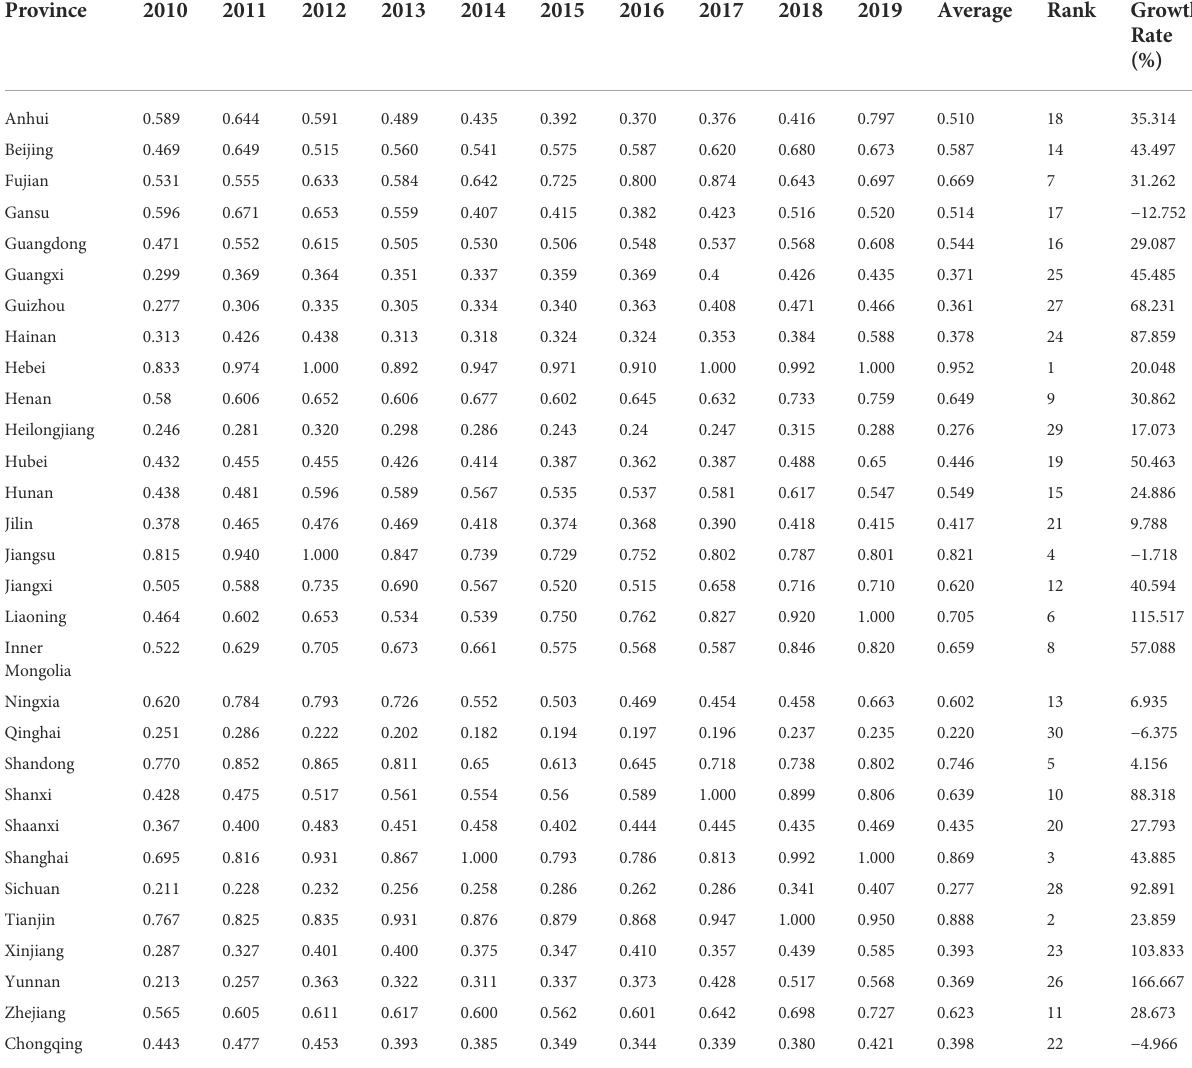
TABLE 4 Carbon emission ef fi ciency of logistics industry in 30 provinces of China from 2010 to 2019.